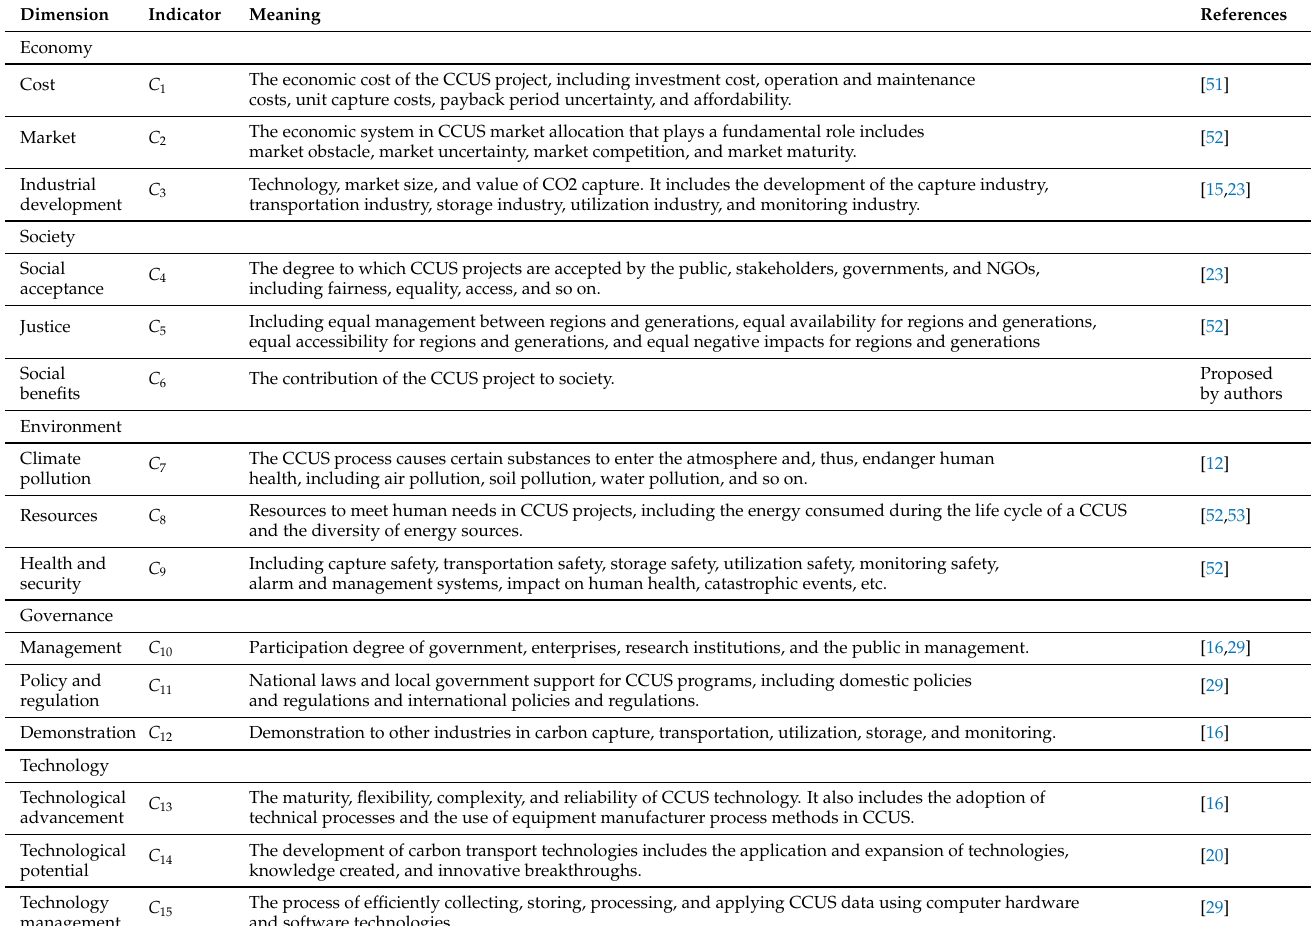
Table 1. The comprehensive risk indicator system for evaluating CCUS